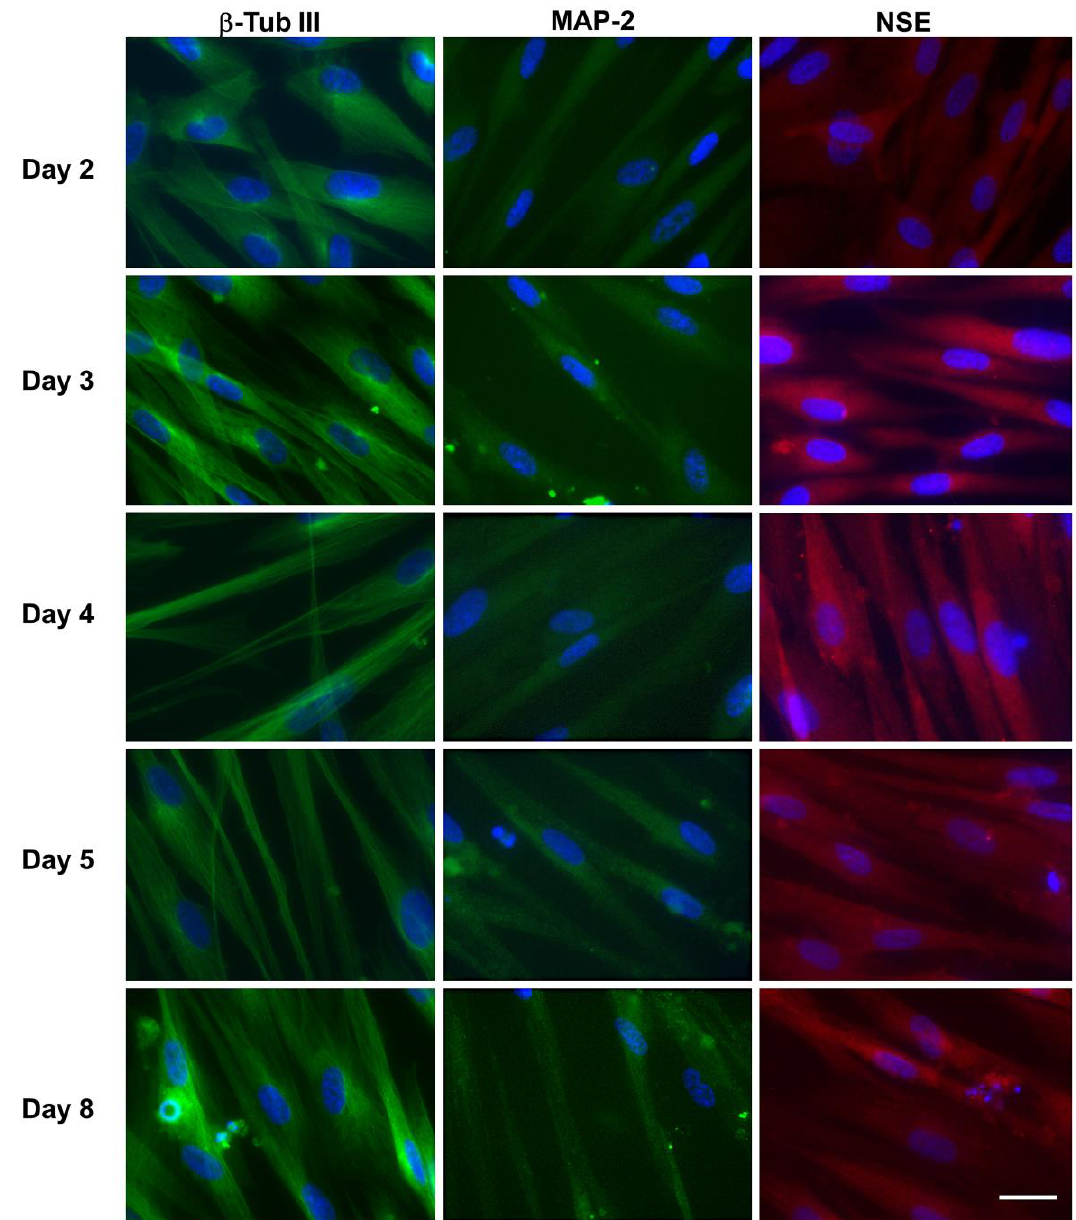
Figure 5. Immunofluorescence analysis of the neuronal marker expression in hNLCs at different time points of transdifferentiation. Representative fluorescence merged microphotographs showing β-Tub III (structural marker), MAP-2 (mature neuron marker) and NSE (cytoplasmic protein expressed by mature neuron) in transdifferentiated hNLCs from day 2 to 8. The fluorescence intensity of β-Tub III (green fluorescence), MAP-2 (green fluorescence) and NSE (red fluorescence) increased in parallel with the progression of neuron-like differentiation of CL-hMSCs cultured in neurogenic medium. Nuclei were stained with Hoechst 33258. Scale bar: 100 μm.